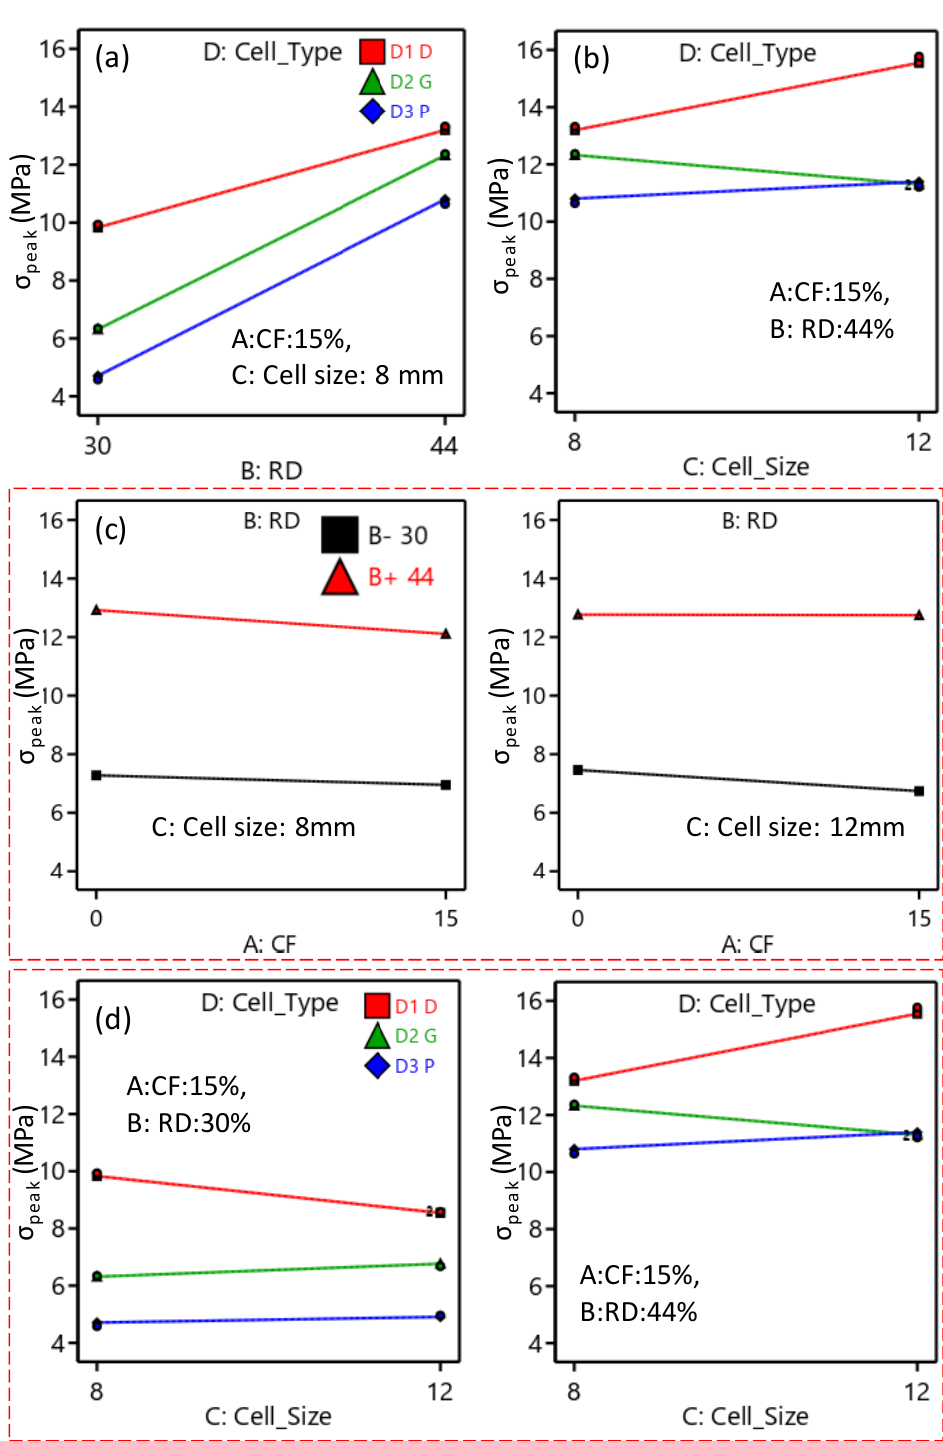
Figure 12. Interaction influence on the σ peak : ( a ) BD interaction, ( b ) CD interaction, ( c ) ABC interac- tion, and ( d ) BCD interaction.